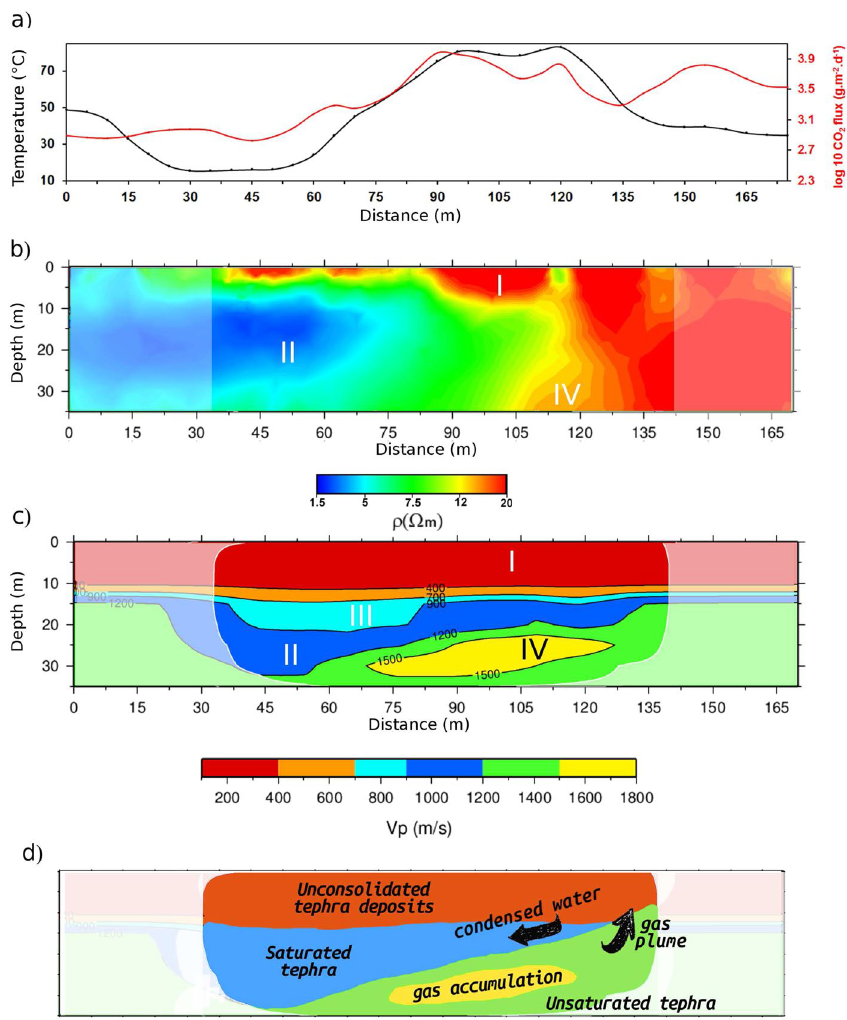
Figure 4. Comparison between temperature (black line) and CO 2 flux (red line) in ( a ), resistivity cross section in ( b ) and P-wave velocity model projected onto the cross-section D in Fig. 3a in ( c ). ( d ) Schematic representation of geological features and fluid flux direction, discussed in the